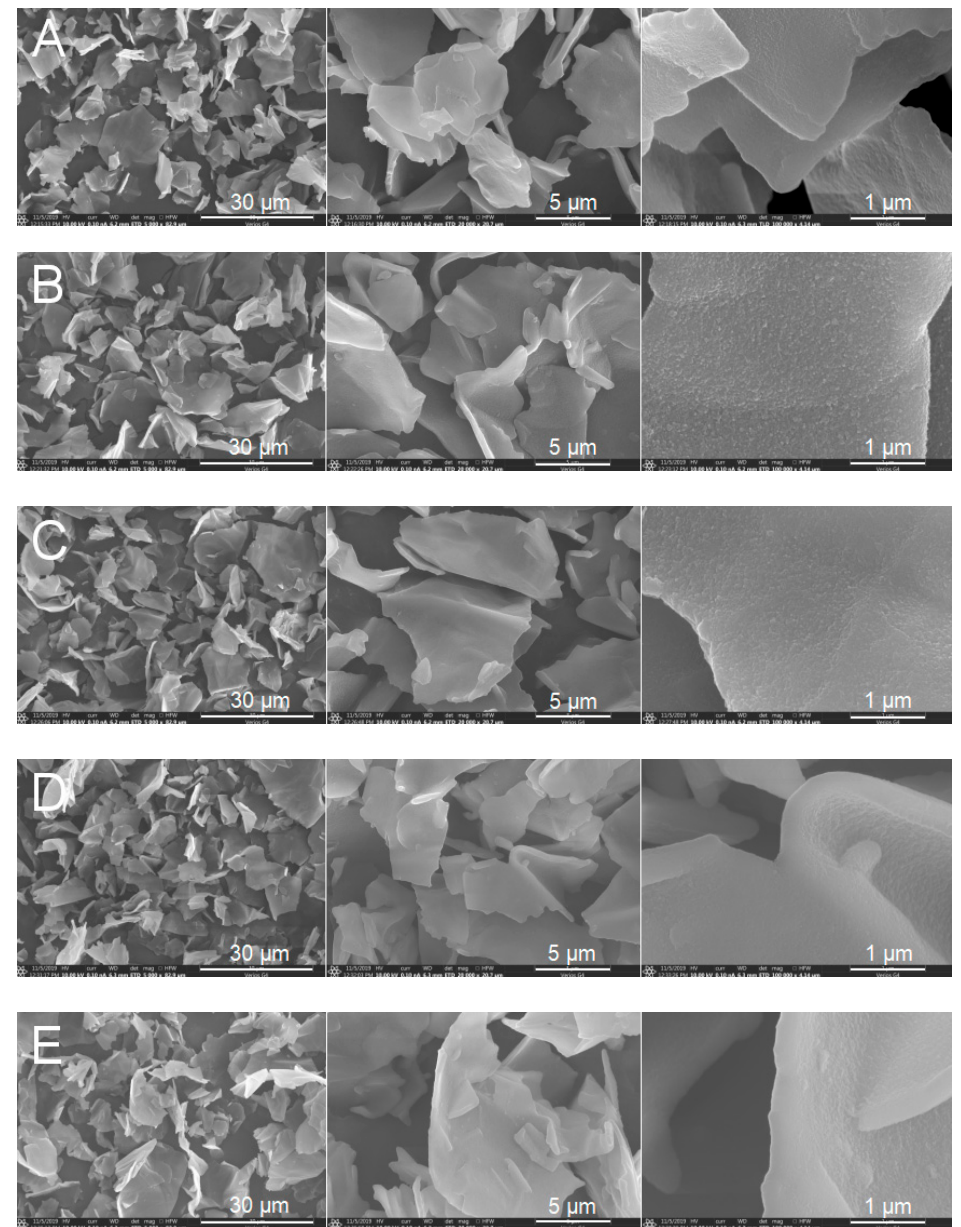
Figure 1. Scanning electron microscope (SEM) images of as-synthesized polyethylaniline shell (PEANI) / graphene oxide (GO) ( A ) PEANI / reduced graphene oxide (rGO) obtained by reduction with hydrazine of 70 μ L ( B ), 140 μ L ( C ), 420 μ L ( D ) and 1400 μ L ( E ).